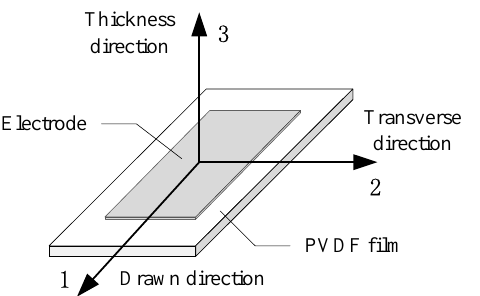
Figure 1. Schematic picture of a PVDF